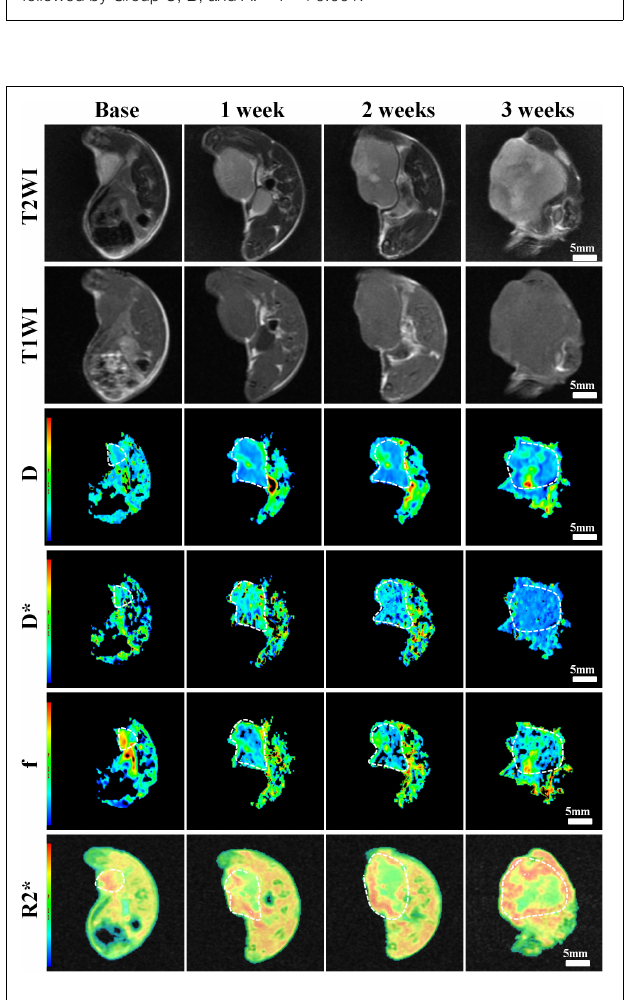
FIGURE 3 | Axial T1WI, T2WI, and pseudocolor maps of D, D*, f, and R2 values at different time points for the control group. D value is the pure diffusion of water molecule. D* value refers to perfusion-related diffusion. F value is the perfusion fraction. R2* value reflects the tumor hypoxia. The white circles plot the tumor